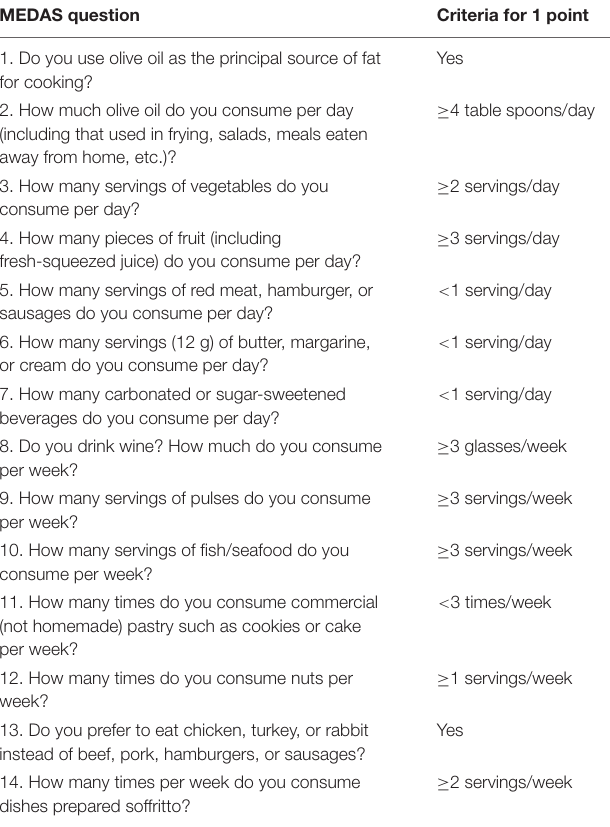
TABLE 2 | Questions and criteria for assessing the adherence to the Mediterranean diet. MEDAS question Criteria for 1